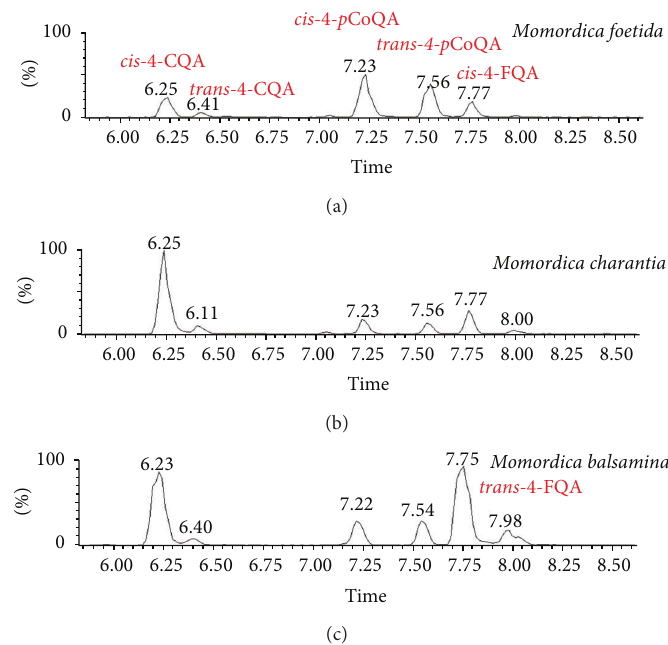
Figure3:RepresentativeUPLC-Q-TOF-MSBPIchromatogramsshowingthedifferentialseparationofthechlorogenicacidsisomersdetected in Momordica